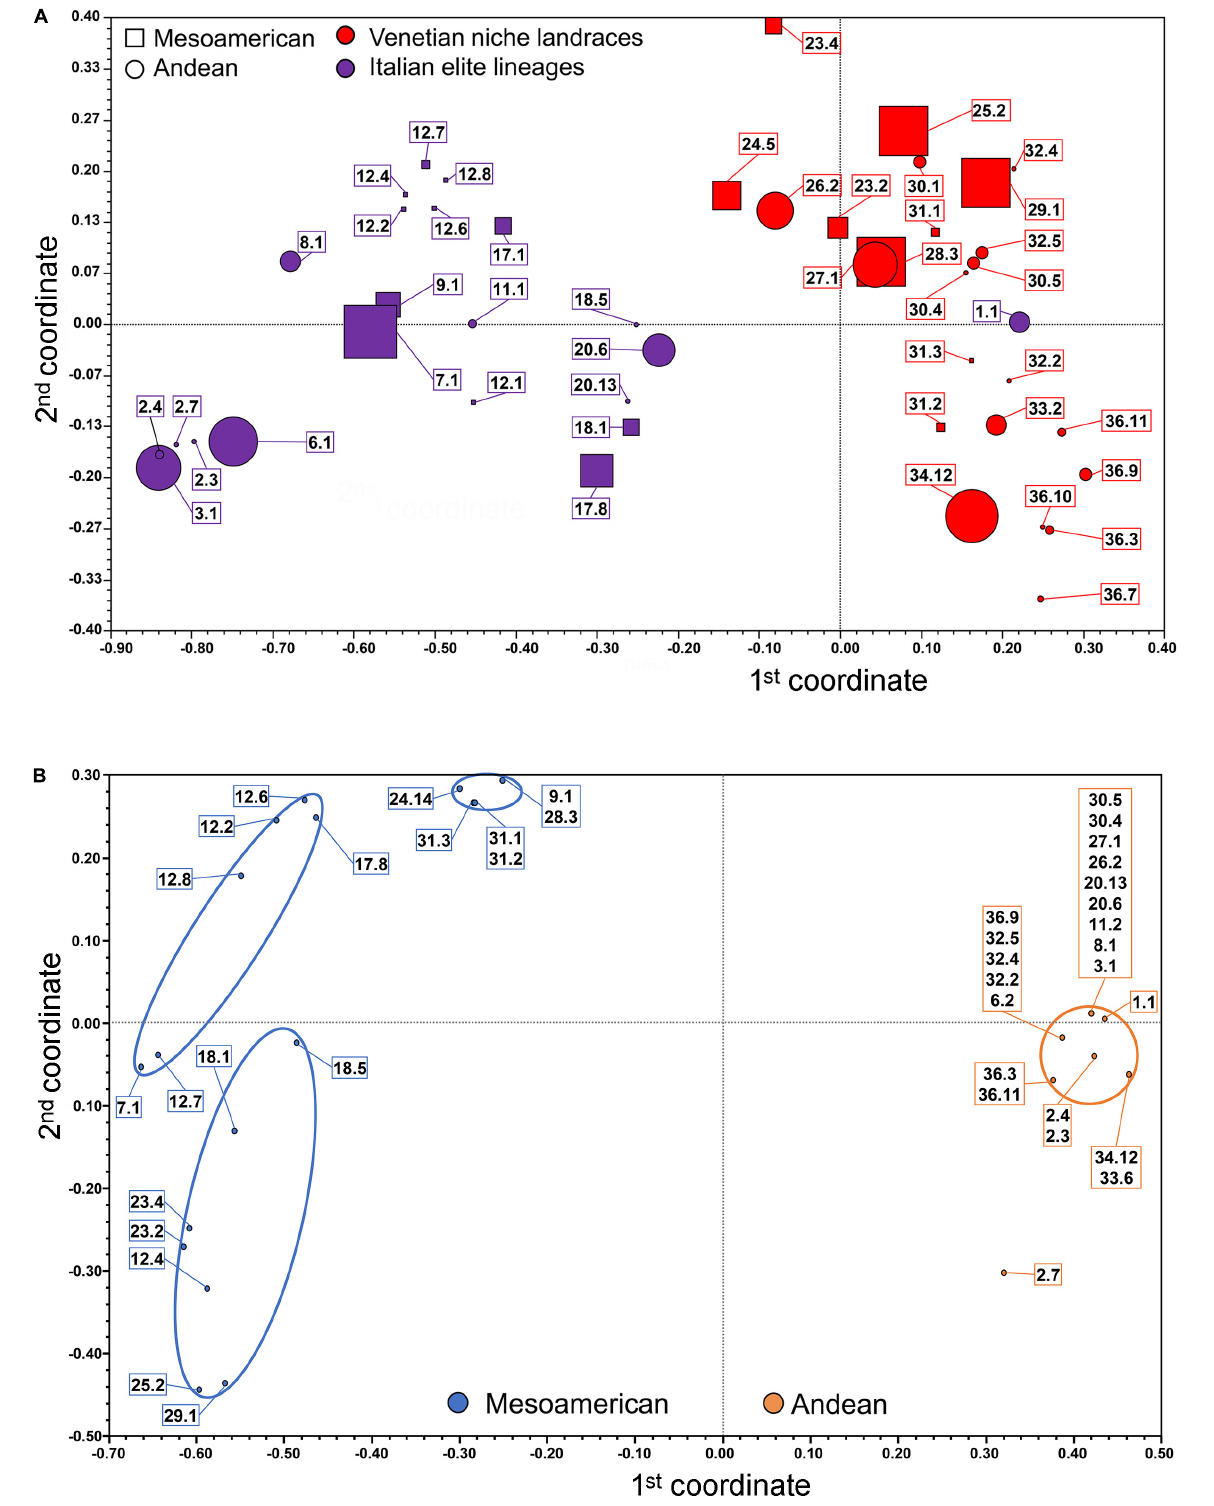
Frontiers in Plant Science |